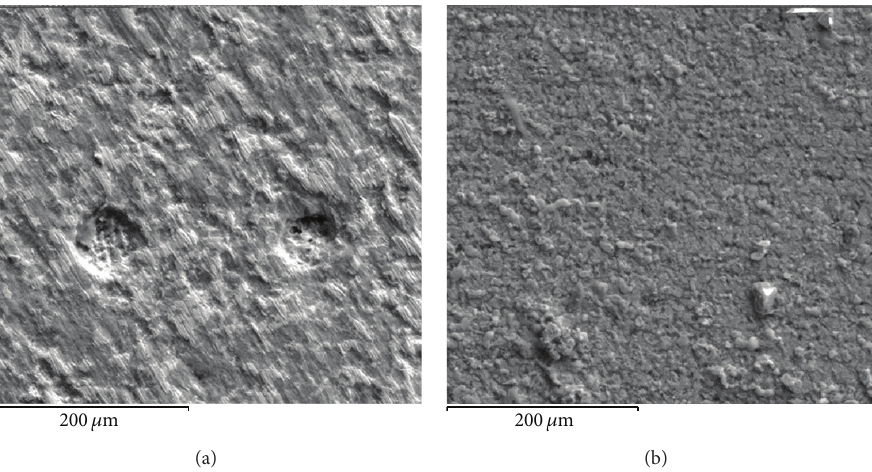
Figure 8: Surface morphology for 1018 carbon steel after the corrosion test: (a) in the base mixture, (b) in the base mixture with CO 2 and inhibitor